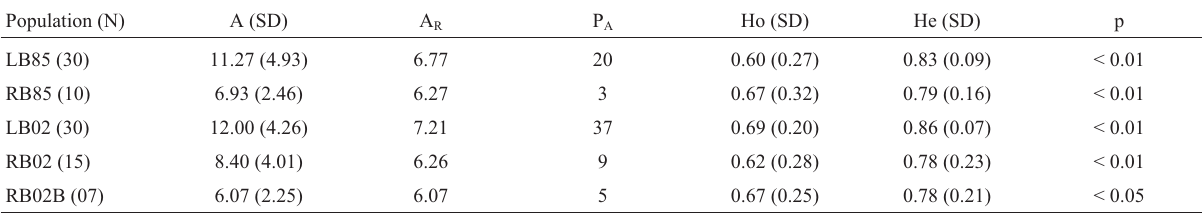
Table 2 - Summary of the characteristics of 15 microsatellite loci in the A. belzebul populations studied at Tucuruí, and analysis of the deviation from Hardy-Weinberg equilibrium. Population